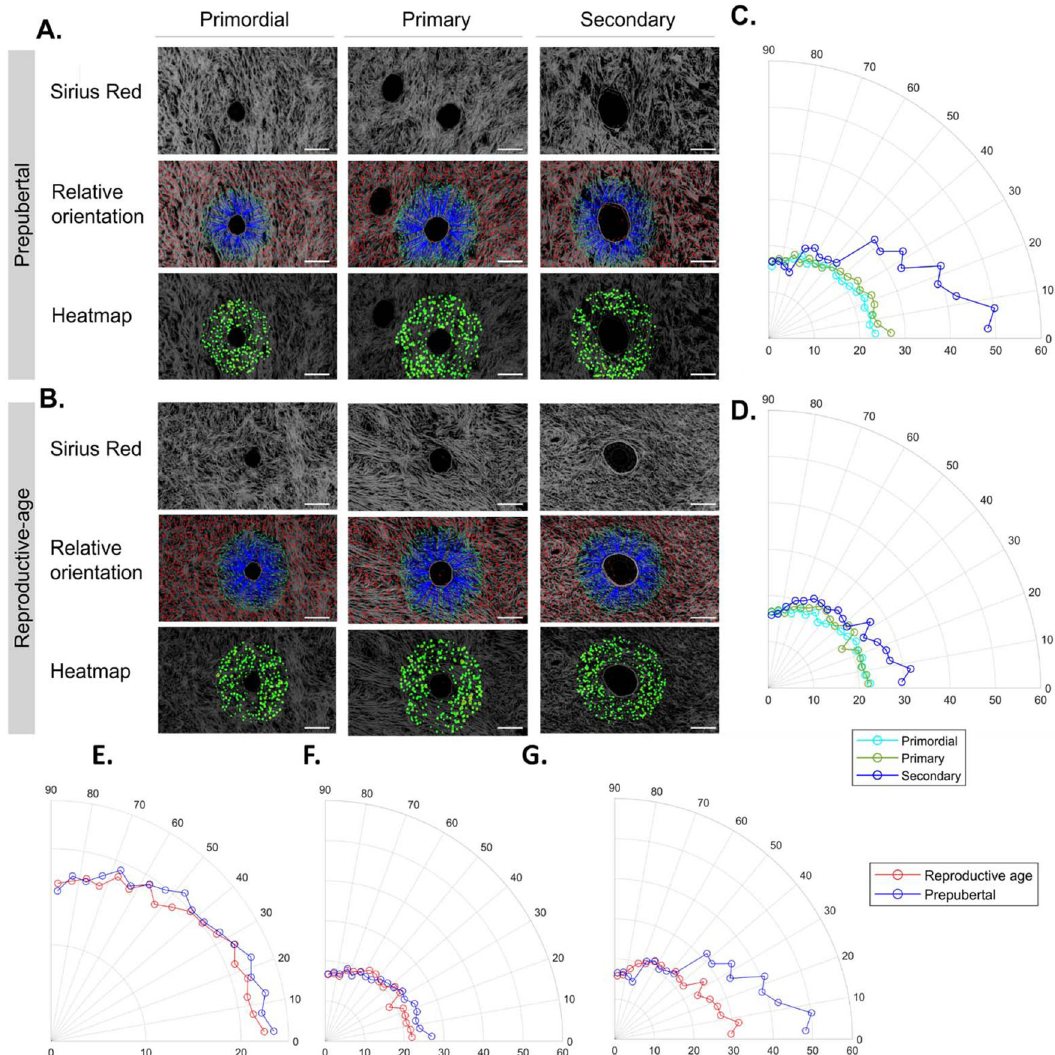
Fig. 4 Fiber orientation in the perifollicular ECM around preantral follicles at prepuberty and reproductive age. A , B Analysis of fi ber orientation around the borders of primordial, primary, and secondary follicles at prepubertal and reproductive age using Sirius Red-stained sections. Details on the number of analyzed fi bers and follicles at each stage and age are detailed in Table 1. The blue line associates the center of fi bers extracted by CT-FIRE with corresponding boundary locations, while the red line shows fi bers located either beyond the distance range or within the boundary; boundaries are highlighted in yellow; the heatmap uses red or warm colors to indicate larger relative angles. C , D Circular plots of fi ber orientation frequency during folliculogenesis in prepubertal ( C ) and reproductive age ( D ) tissues revealed signi fi cant fi ber reorientation at the secondary stage compared to primordial and primary stages and at both ovarian ages. One-way ANOVA (post hoc: Tukey) was used to compare fi ber directionality between follicle stages within each age group. During prepuberty ( p values): P primordial – primary = 0.9191; P primordial – secondary = 0.0010; and P primary – secondary = 0.0034. During reproductive age ( p values): P primordial – primary = 0.8574; P primordial – secondary = 0.0022; and P primary – secondary = 0.0099. E – G When comparing the difference in fi ber orientation around follicles from prepubertal and reproductive-age tissues at each follicular stage ( E : primordial, F : primary, and G : secondary), we found signi fi cant differences between age groups at all stages. P primordial = 0.0026; P primary = 0.0329; and P secondary < 0.0001. One-tailed t test was used to compare fi ber directionality around follicles at the same stage between age groups. Scale: 200 µ